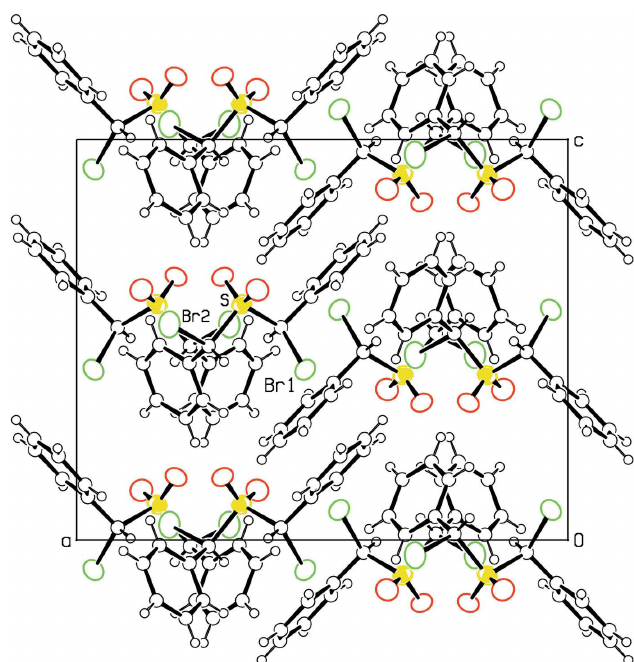
Figure 3 Projection of the crystal structure of 2 down the b axis. An arbitrary sphere size is given for C and H atoms, and a 50% probability level for the displacement ellipsoids of Br, S and O atoms. The reference molecule has Br and S atoms